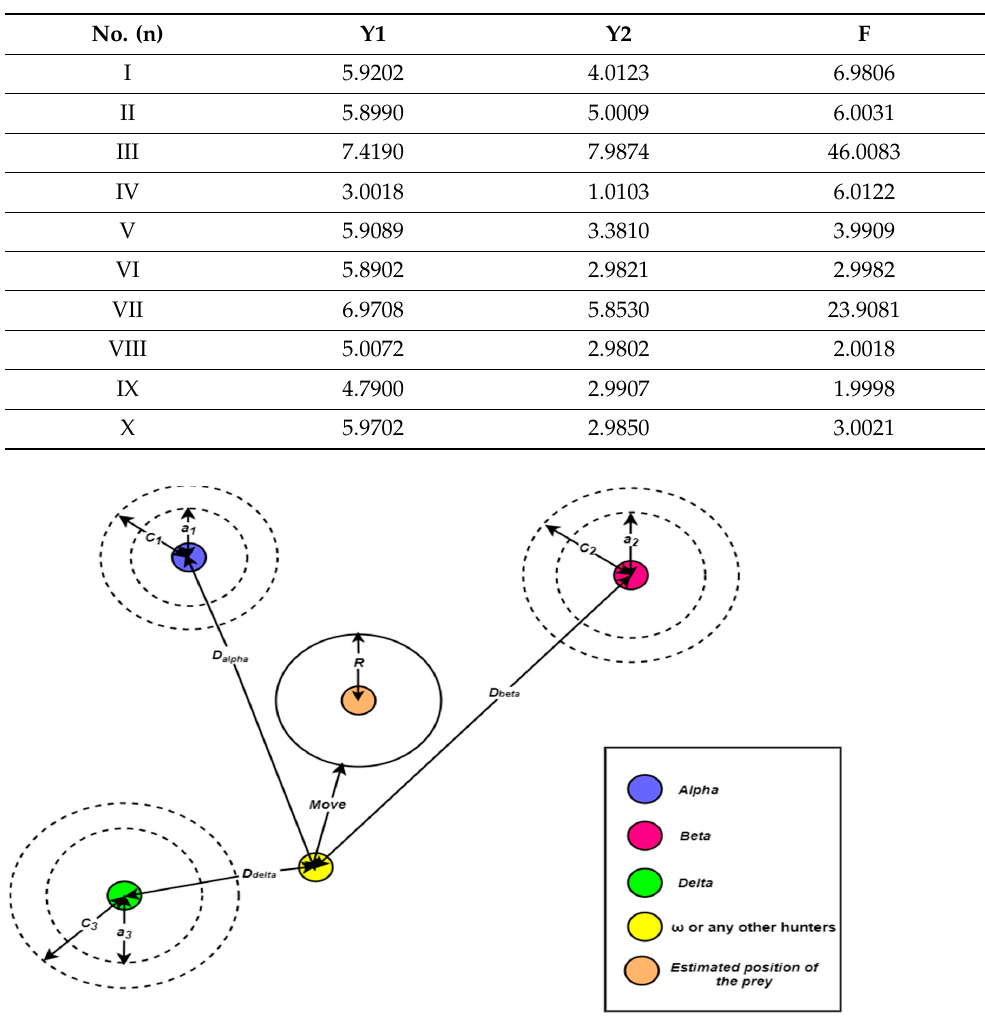
Figure 5. Updating process of the positions of the wolves.